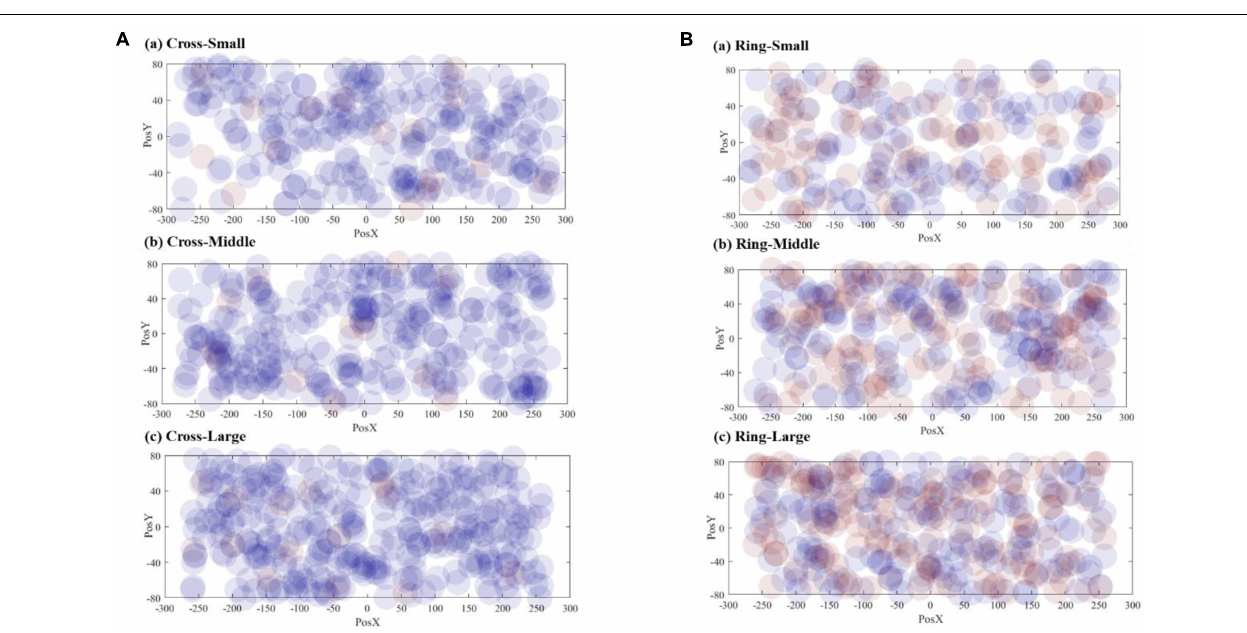
responses. Figure 10 forms the result into a contour map, using a spectrum of warm color to cold color to represent the adjusted correct response values from high to